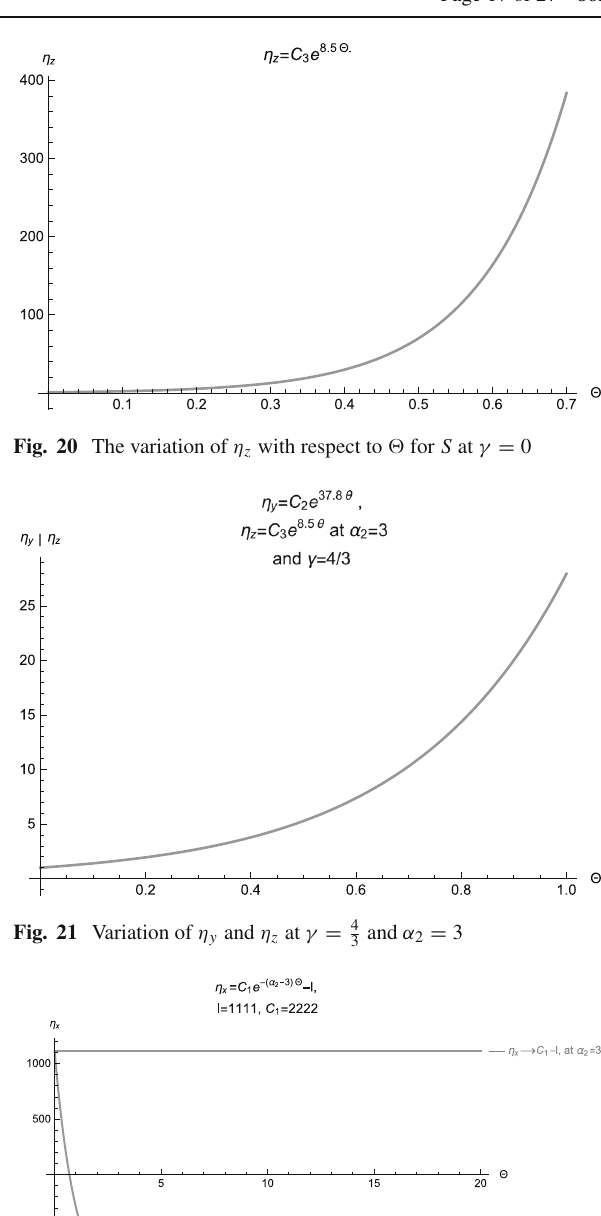
X = x − l , Y = y − 0 . 0009 , Z = z